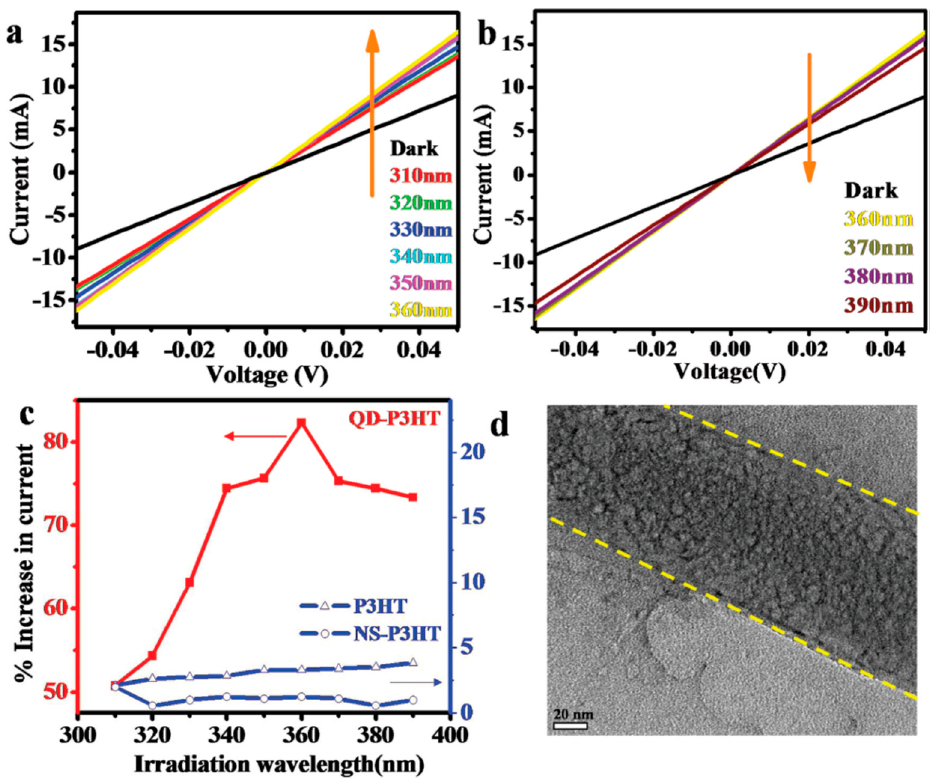
Figure 19. ( a ) Wavelength-dependent I-V measurements on the QD-P3HT hybrid with excitation from 310 to 360 nm (in increments of 10nm); ( b ) wavelength-dependent emission from 360 to 390 nm (in increments of 10nm); ( c ) percentage change in photoconductivity (with respect to dark conditions for that material) in P3HT fibers, QD-P3HT and NS hybrid as a function of wavelength; ( d ) high magnification TEM showing MoS 2 QDs embedded inside a P3HT fiber. Reproduced with permission from [152]. Copyright The Royal Society of Chemistry, 2018.